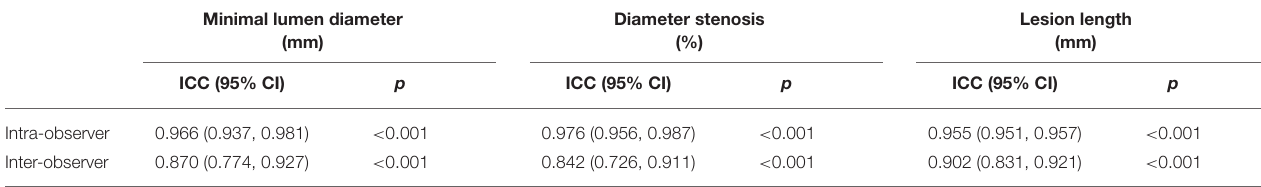
TABLE 4 | Intra-and inter-observer variability analyses of lesion